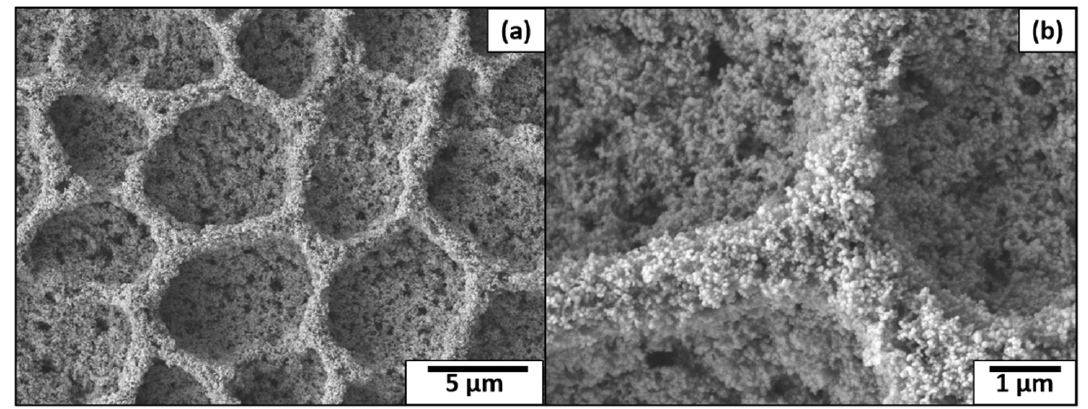
Figure 2. SEM images of superhydrophobic nanocomposite coating at ( a ) ×4300 magnification, and ( b ) ×1600 magnification.